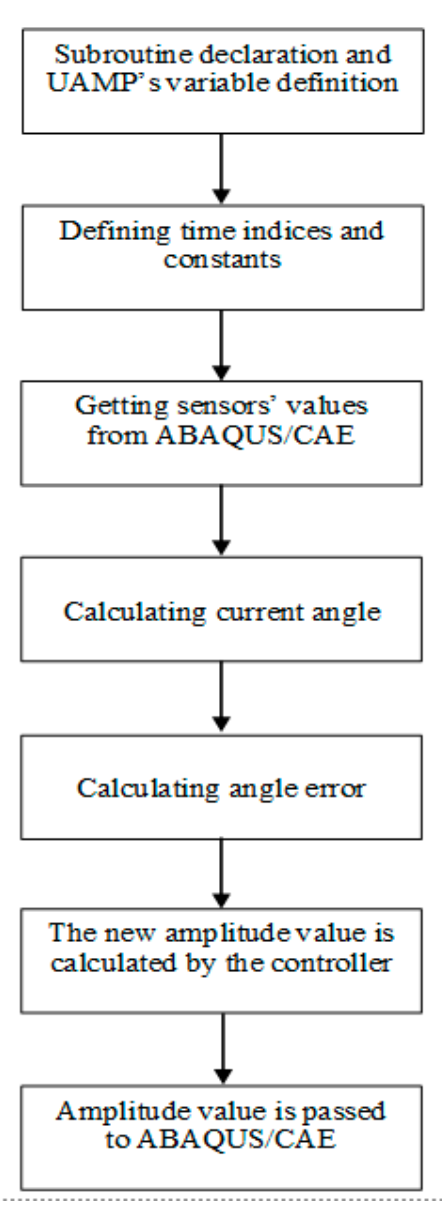
Figure 18. Flow chart of the UAMP subroutine. The sensors’ values are passed to the subroutine from ABAQUS. Z_Upper represents the z-displacement of the upper node. Z_Lower represents the z-displacement of the lower node. Y_Upper represents the y-displacement of the upper node. Y_Lower represents the y-displacement of the lower node. The current bending angle is calculated by the following equation: CurrentAngle = 90 − ATAN((Z_Upper − Z_lower)/(Y_Lower − Y_Upper)) * 180/ π (1) Error in angle is calculated and controller action is determined to process the new amplitude value, which is passed to ABAQUS to proceed with the simulation. This loop is repeated each time step. The closed loop block diagram is shown in Figure 19. The full code used can be found in Appendix A.